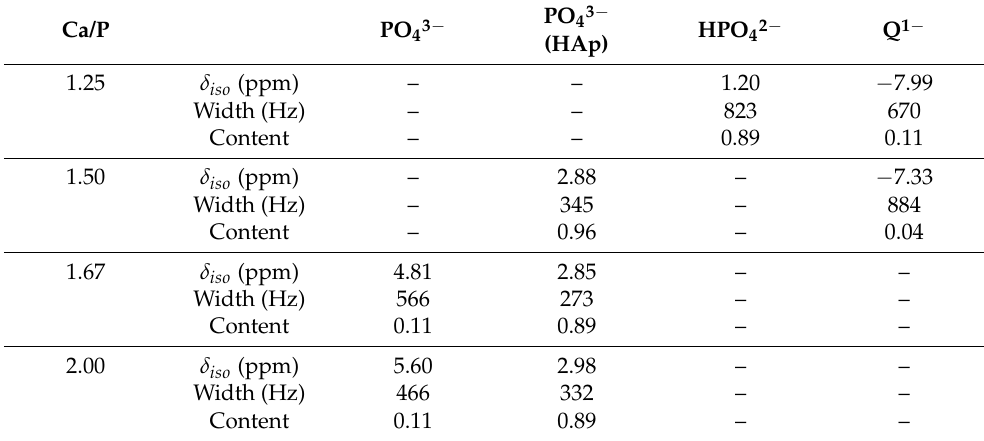
Figure 8. 31 P ( a ) and 1 H ( b ) MAS NMR spectra of the synthesized samples with different Ca/P ratios. Table 3. 31 P chemical shift parameters for the synthesized